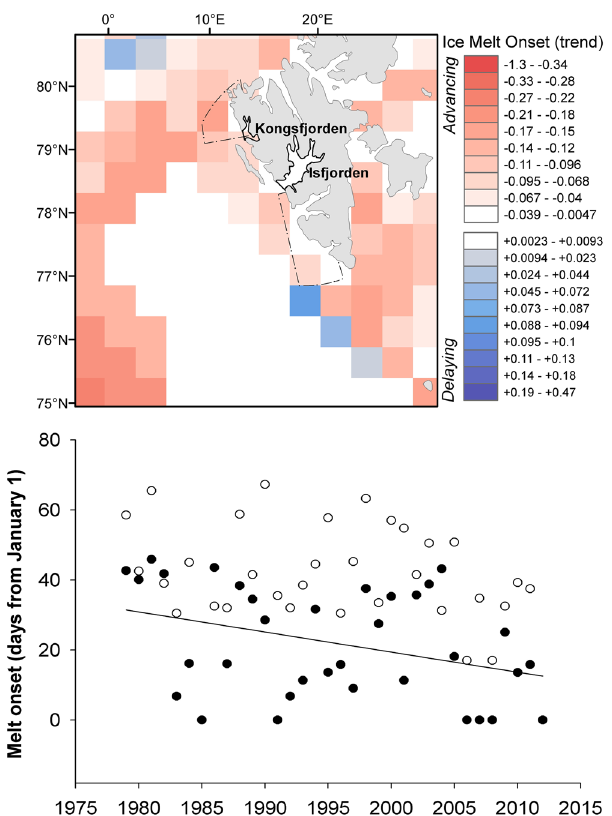
Figure 4. Spatially-explicit trends in the melting phenology. The map represents the slopes of the pixel-based, least squares linear regressions of snow melt onset dates for the 1979–2012 period and reveals the uneven distribution of environmental trends. The average date at which the onset of the melting process occurs annually within each seabird foraging area is also represented in a scatterplot (little auk, black dots; Brünnich’s guillemot, white dots) to show the species-specific changes in the environmental conditions that seabirds are facing. Map generated with ArcGIS 10.2.1 (ESRI, Redland), www.arcgis.com. Organizational License provided by